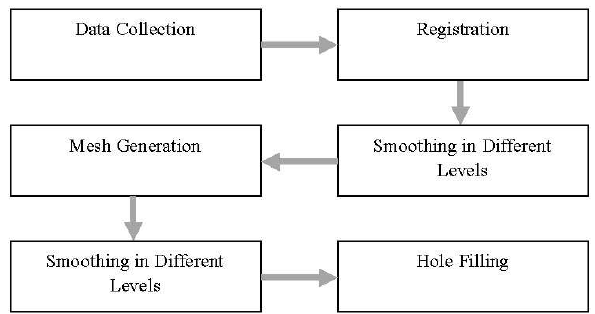
Figure 4. General workflow data processing